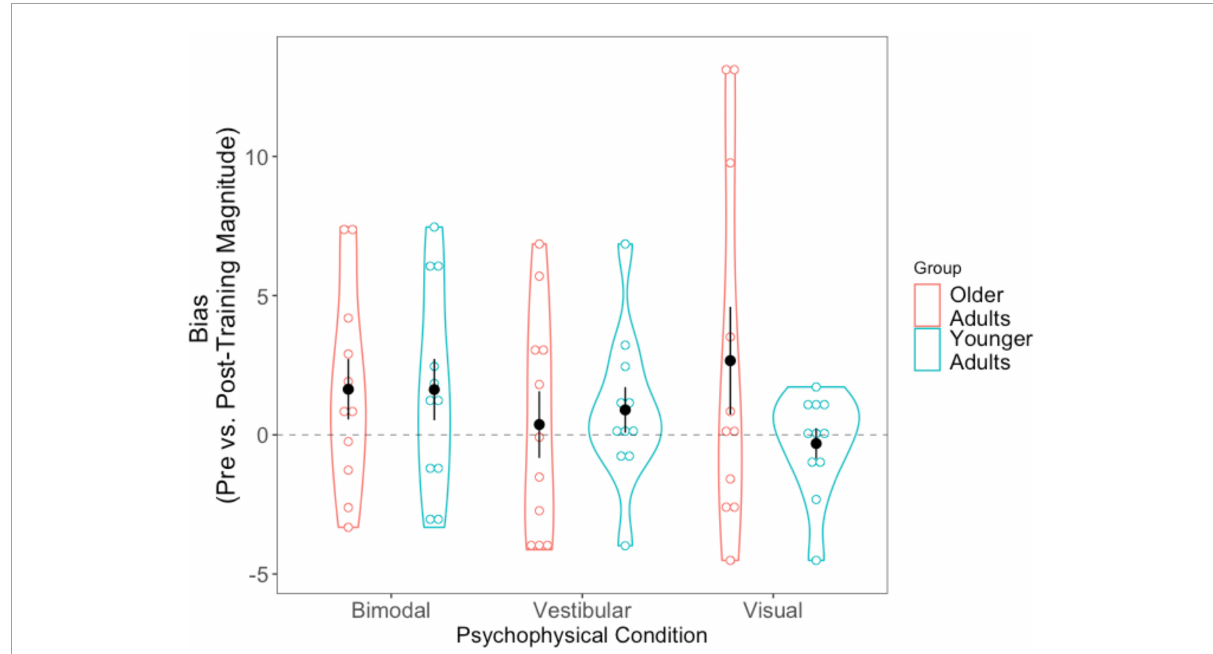
FIGURE8 Difference scores for bias, across all three psychophysical conditions, for each of the two age groups. Black dots represent means, and error bars represent standard error. Individual data points are represented by the blue (younger adults) and red (older adults) circles. Black dashed line indicates a bias no closer to true straight ahead following training.